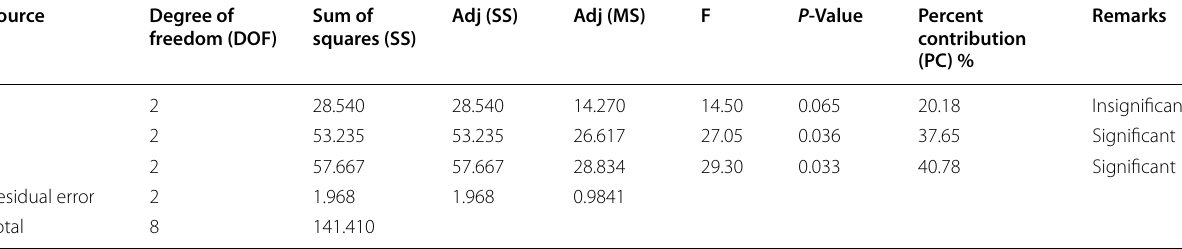
Table 10 ANOVA optimization Source